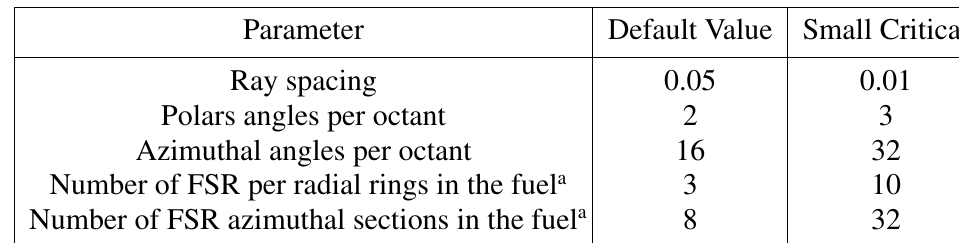
Table 1: MPACT mesh convergence